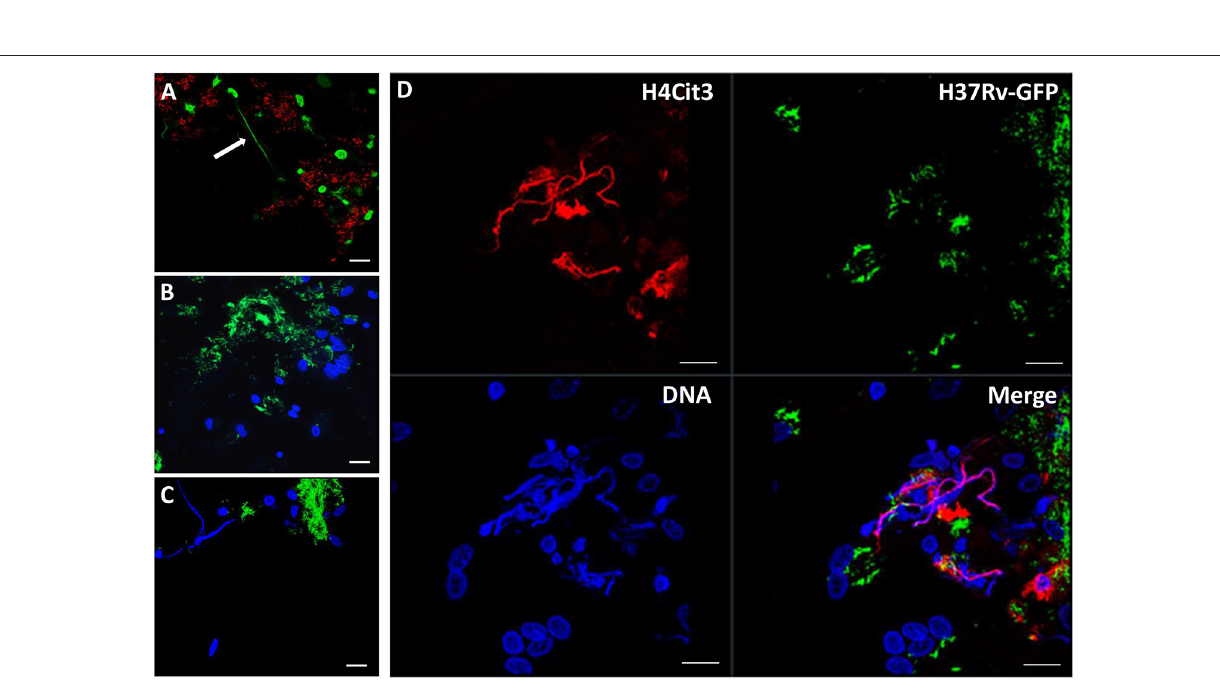
Frontiers in Cellular and Infection Microbiology | www.frontiersin.org